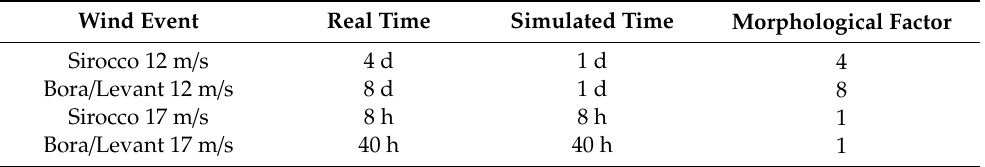
Table 1. Sequence of real and simulated winds representative of the average year and the relative morphological factor applied to each class.